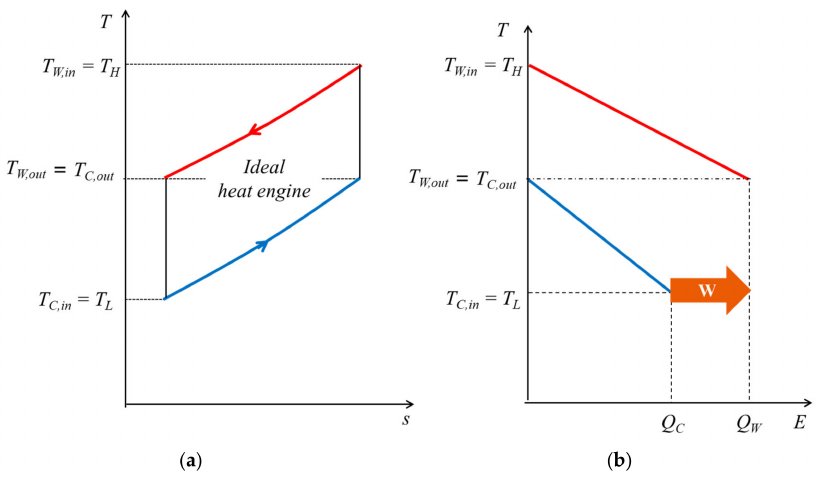
Figure 5. Conceptual diagrams of an ideal heat engine for OTEC with infinite performance of heat exchangers. The heat engine temperature varies and completely follows the seawater temperature change during the heat transfer process. T H and T L are the highest and lowest temperatures in the heat engine, and they reach T W,in and T C,in , respectively; ( a ) T – s diagram; ( b ) T – E